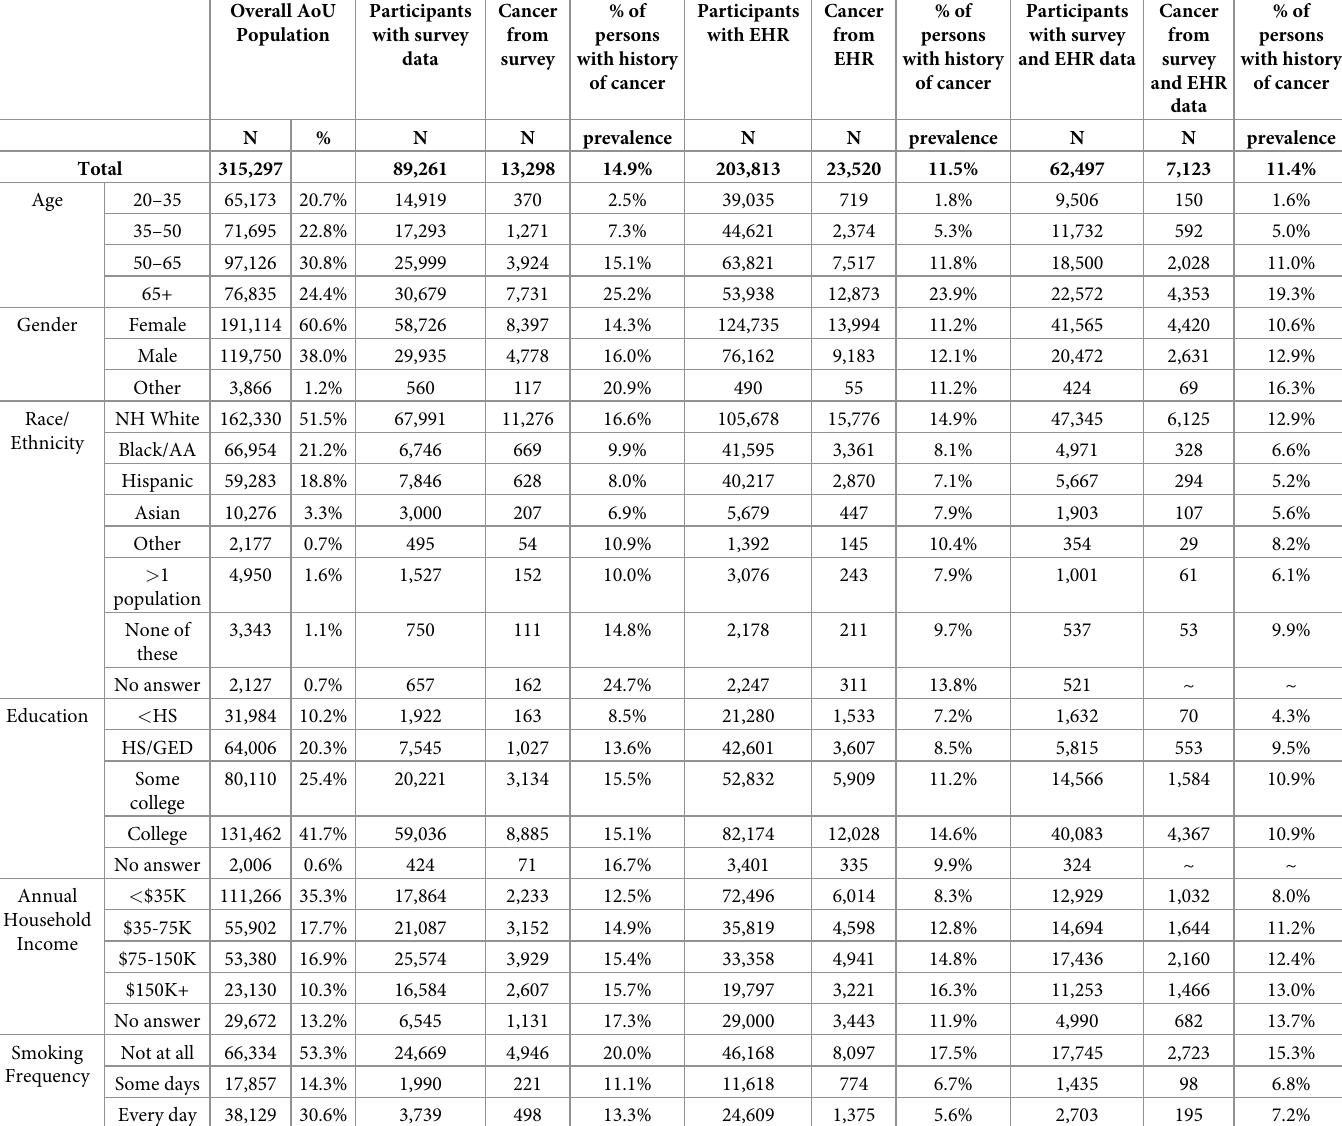
Table 1. Comparison of characteristics of participants with cancer to the broader All of Us study population using self-reported survey data and electronic health